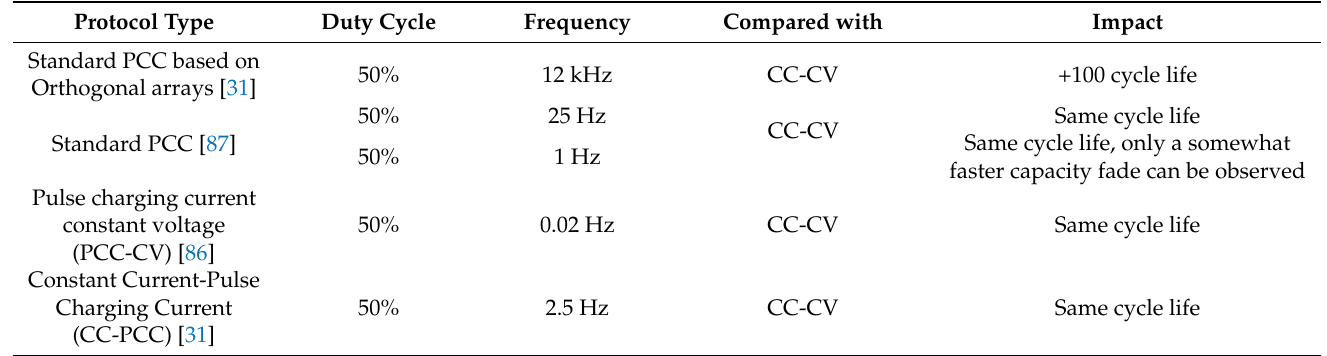
Table 3. Comparison between different types of Positive Pulsed Charging Current (PPCC)